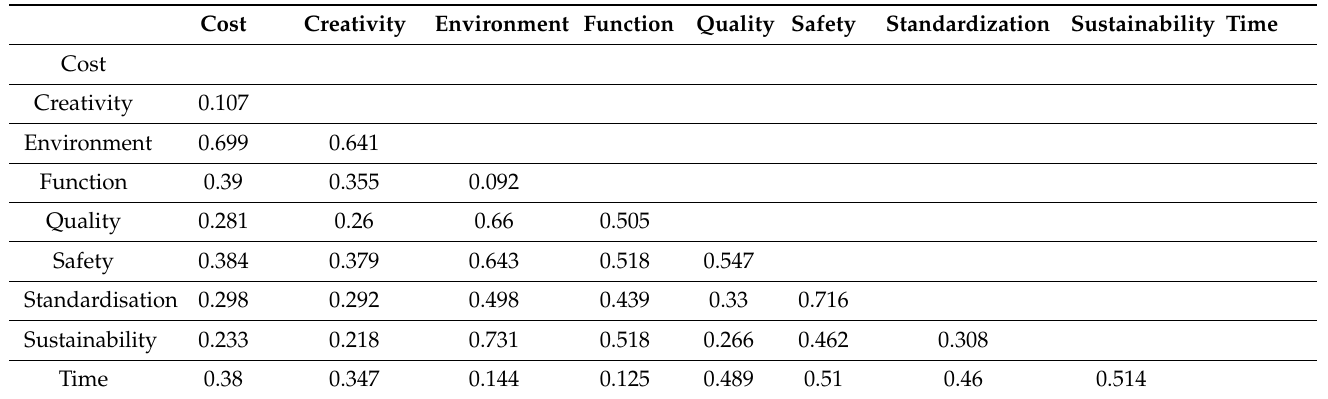
Table 6. HTMT statistics.